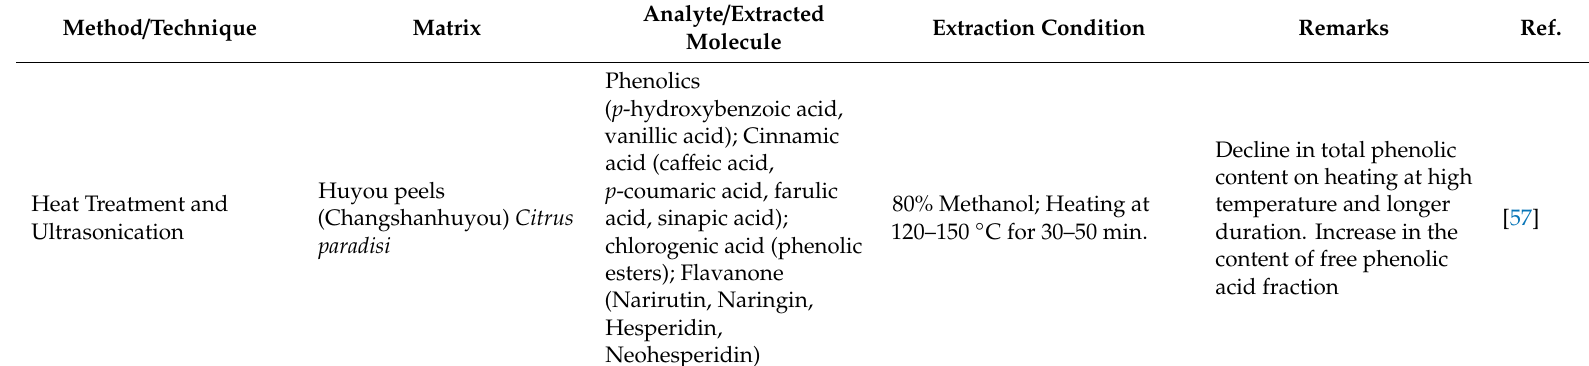
Table 12. Recent reports on extraction of important value-added compounds from citrus wastes involving conventional and modern